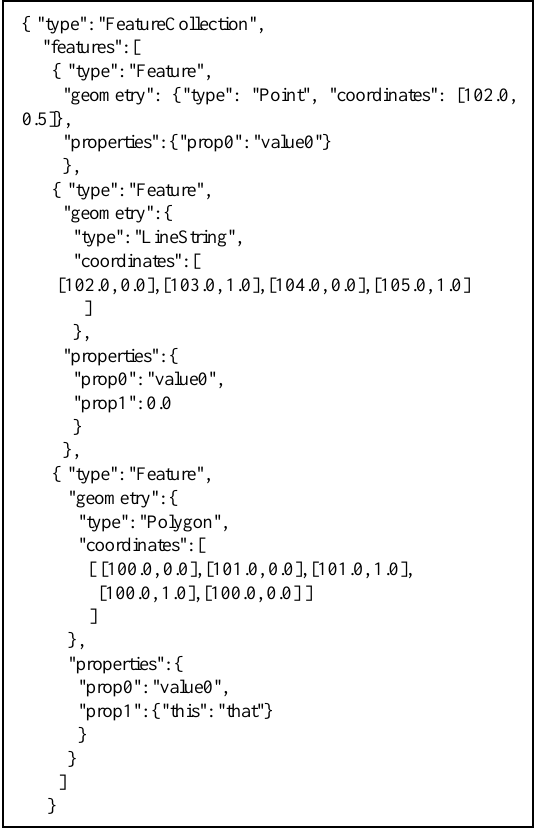
Figure 1: Sample GeoJSON Code